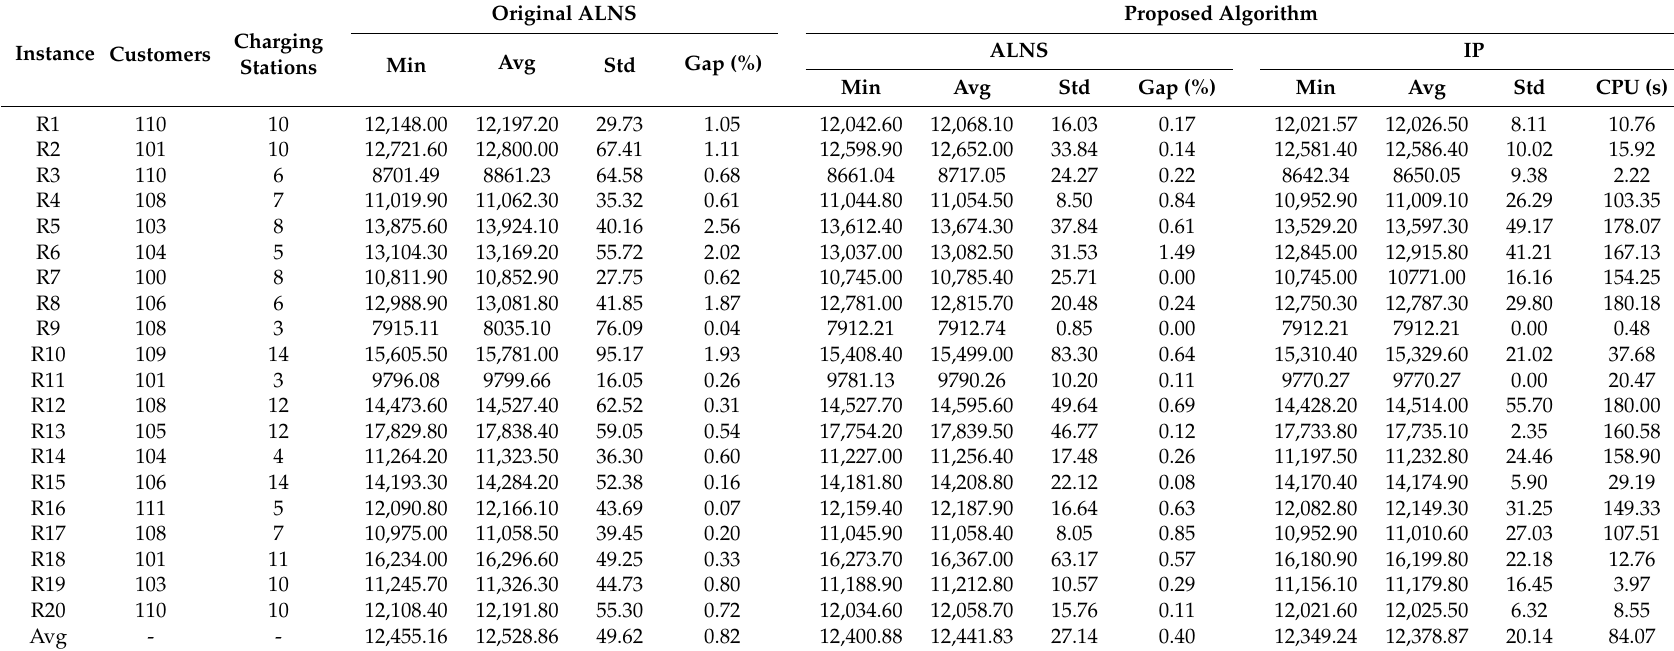
Table 4. Results of instances obtained by the proposed